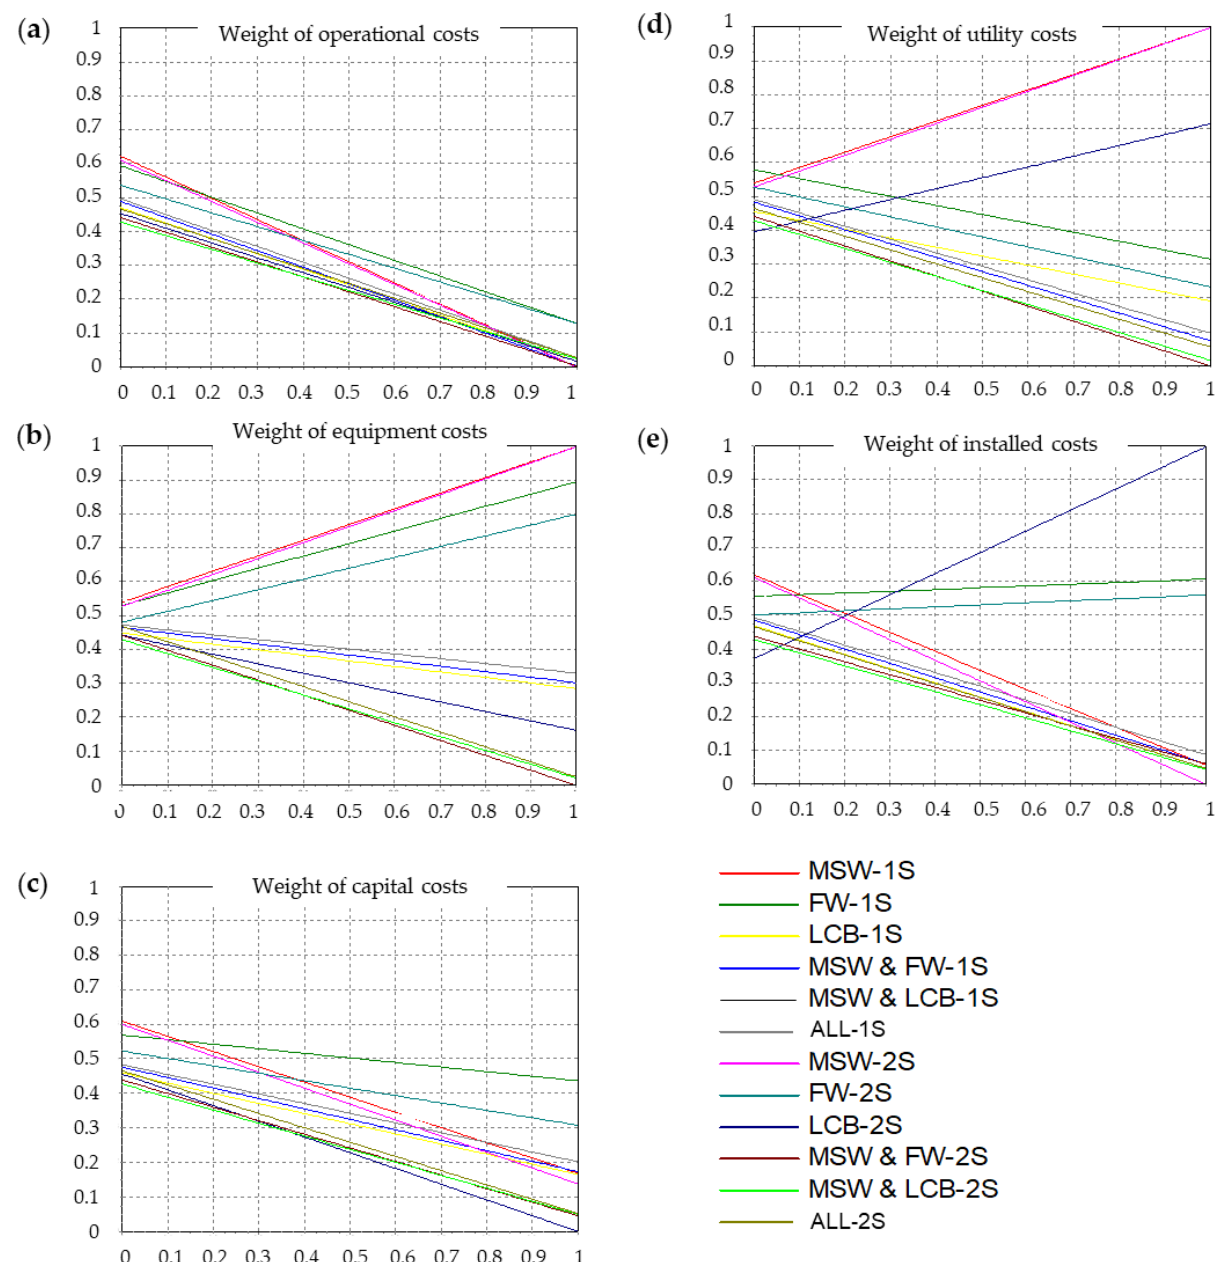
Figure 6. Sensitivity analysis of the ranking of the biogas plant alternatives to the weightings of the criteria: ( a ) operating costs; ( b ) equipment costs; ( c ) capital costs; ( d ) utility costs; ( e ) installed costs.